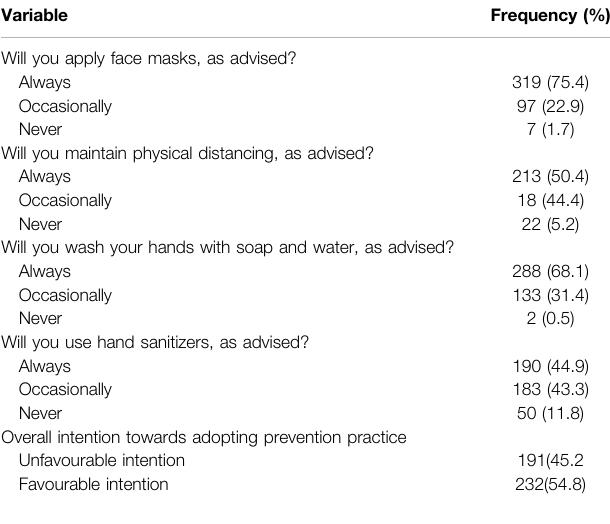
TABLE 4 | Participants ’ intention of adapting the ‘‘ new normal ’’ COVID-19 prevention practice-related characteristics of in Debre Berhan University, Northeast Ethiopia, 2021 ( n (cid:1)